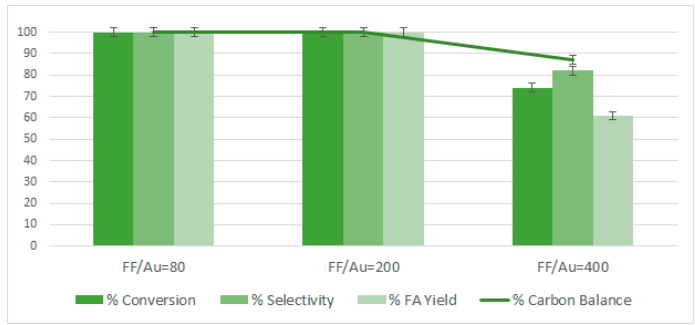
Figure 9. Effect of the FF/Au molar ratios using Au/HT 4:1 catalyst. Furfural oxidation, batch reactor, Figure 9. E ff ect of the FF / Au molar ratios using Au / HT 4:1 catalyst. Furfural oxidation, batch reactor, p = 6 bar (O 2 ), t = 110 °C, 600 rpm, 2h, [FF] = 26 mM. p = 6 bar (O 2 ), t = 110 ◦ C, 600 rpm, 2h, [FF] = 26 mM.